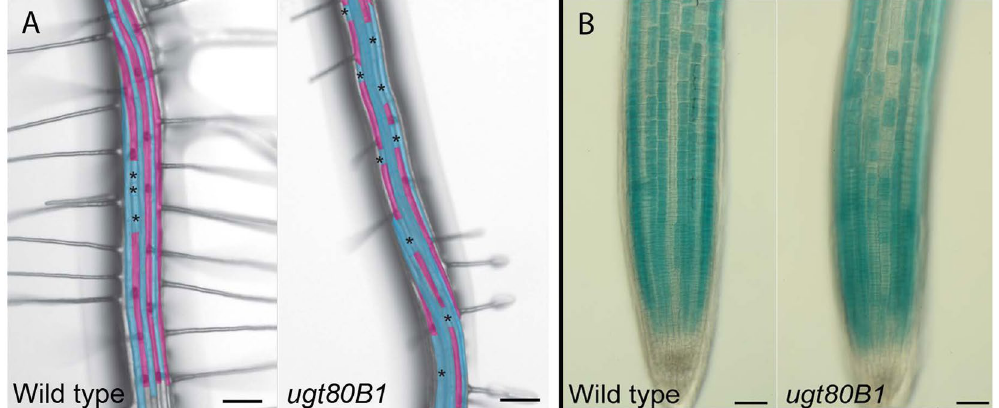
Figure 3. Root hair patterning and GL2 expression are aberrant in ugt80B1 mutants. ( A ) Brightfield microscopy images with false coloration to indicate H (cyan) and N (magenta) cells (scale bar = 100 μ m). Black asterisks mark ectopic N cells in an otherwise H cell file. ( B ) The proGL2:GUS reporter was used to identify cells expressing GL2 (scale bar = 50 μ m). In wild-type roots, cell files in the N position consistently express GL2 whereas those in the H position do not. In ugt80B1 mutant roots, proGL2:GUS expression appears